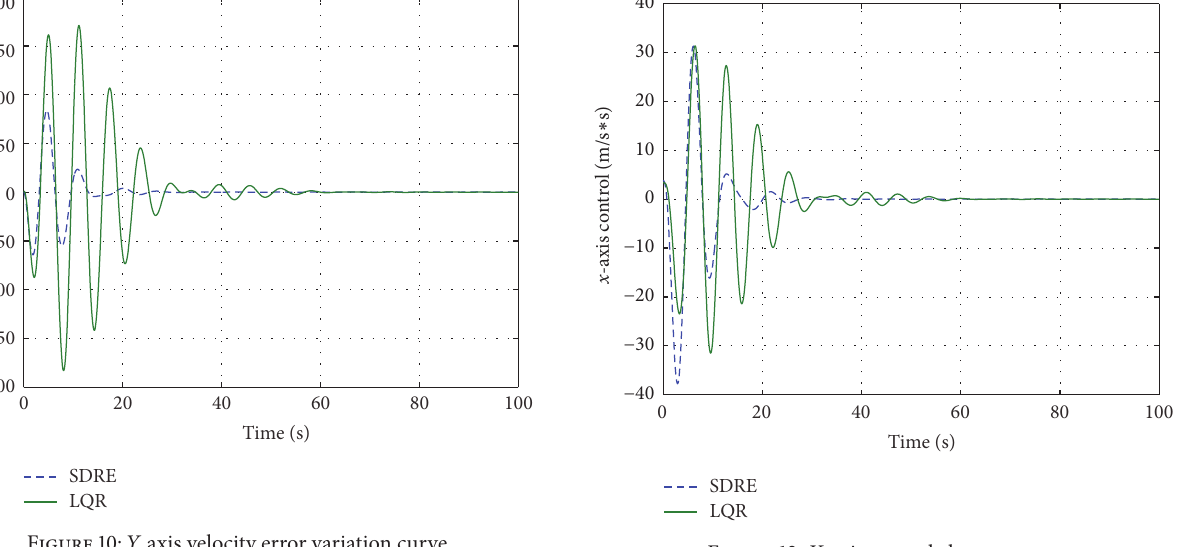
Figure 12: 𝑋 axis control change curve.